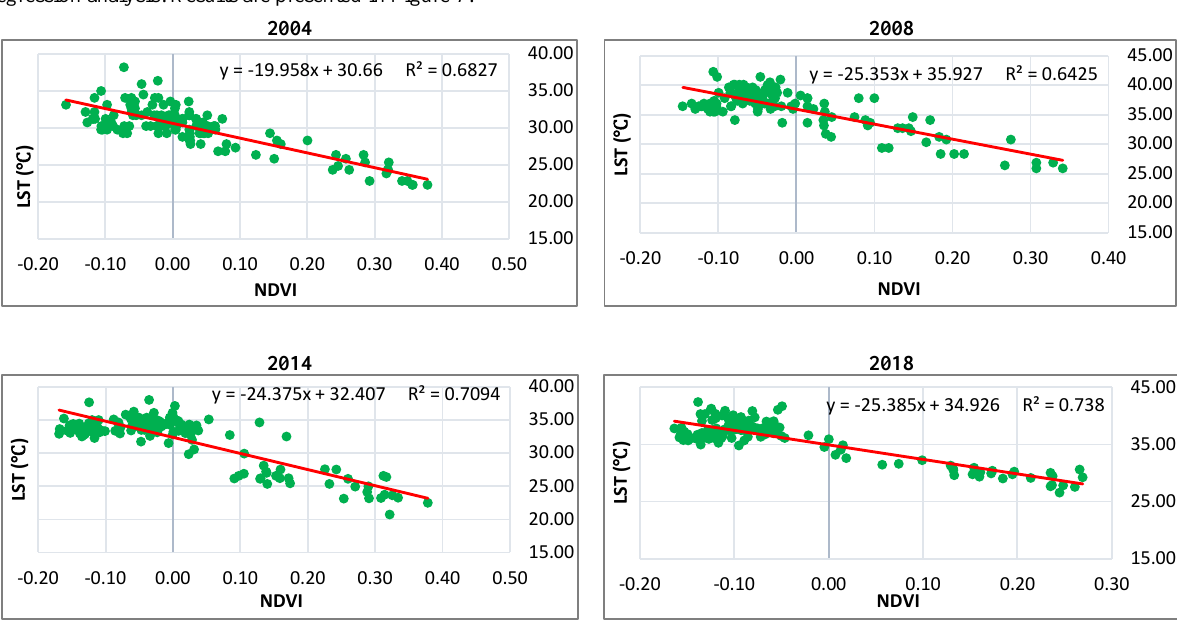
Figure 7. Correlation analysis between LST and NDVI in 2004, 2008, 2014 and